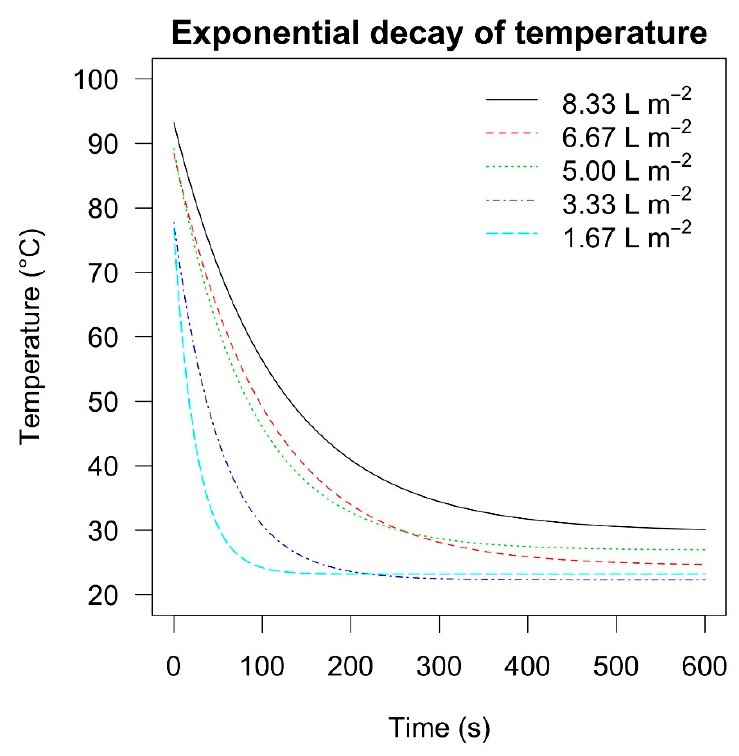
Figure 2. Exponential decay curves of temperature as affected by the foam dose (0, 1.67, 3.33, 5.00, 6.67, and 8.33 L m -2 ) and by the passage of time. The parameters of the non-linear regression are reported in Table 1.